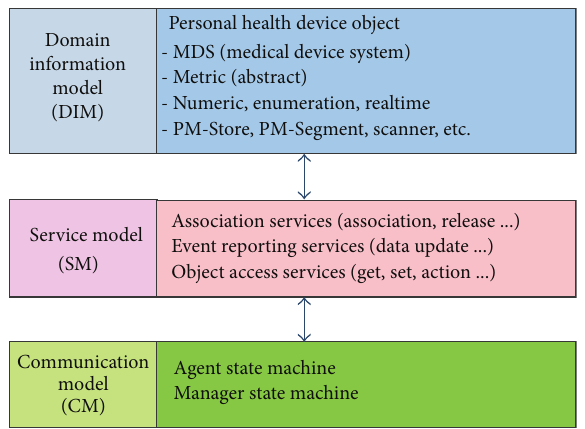
Figure 5: The X73 protocol stack of a sensor node.